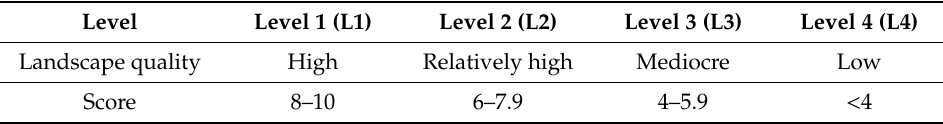
Table 3. Grading division of FLQ for forest